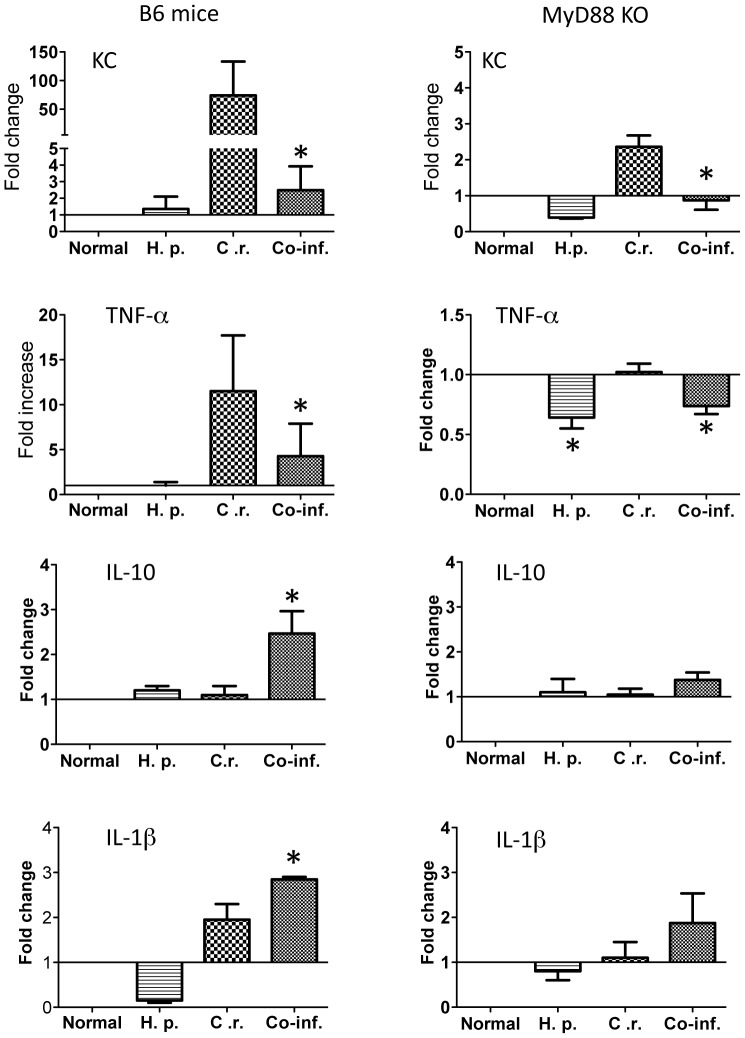
Co-infection with H. polygyrus results in dysregulation of Citrobacter-induced colonic cytokines.Colon tissues were collected from normal control, C. rodentium-infected, H. polygyrus infected, and co-infected wild-type C57BL/6 and MyD88 knockout mice. Total RNA was isolated. The expression of KC, TNF-α, IL-10 and IL1β was determined using quantitative RT-PCR. Values are the fold increase compared with baseline obtained from uninfected mice. The data shown are the mean ± the SEM (n = 3–5 mice/group) from one of three experiments performed showing similar results. *p<0.05.